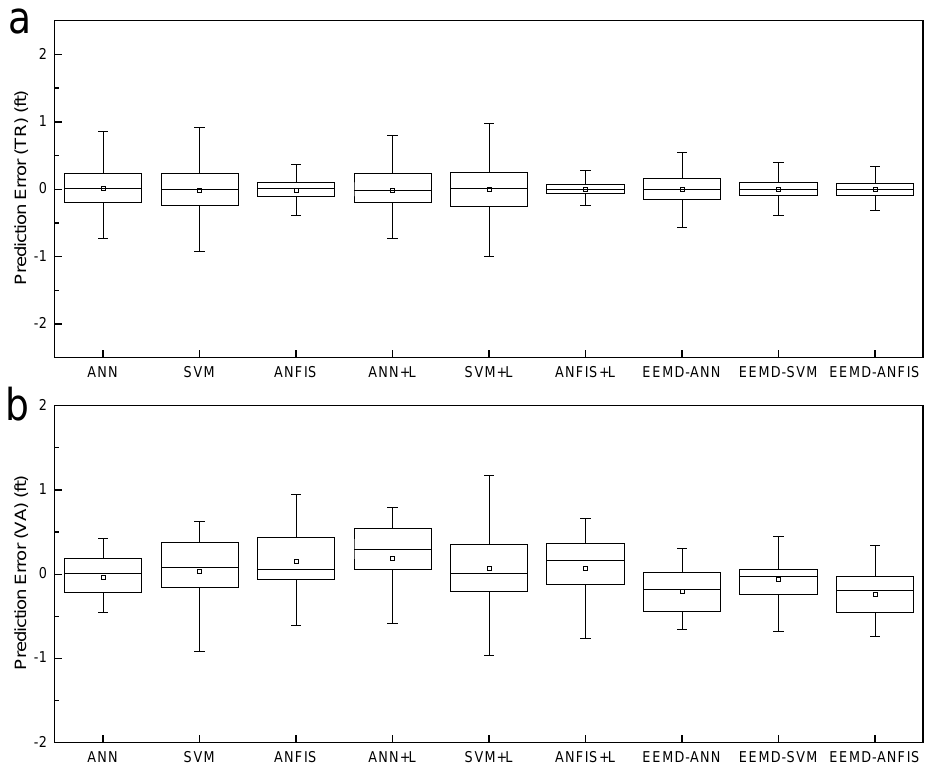
Figure 17. Box plots of the prediction error at site M1255 ( a ) Tr—Training; ( b ) Va—Validation.